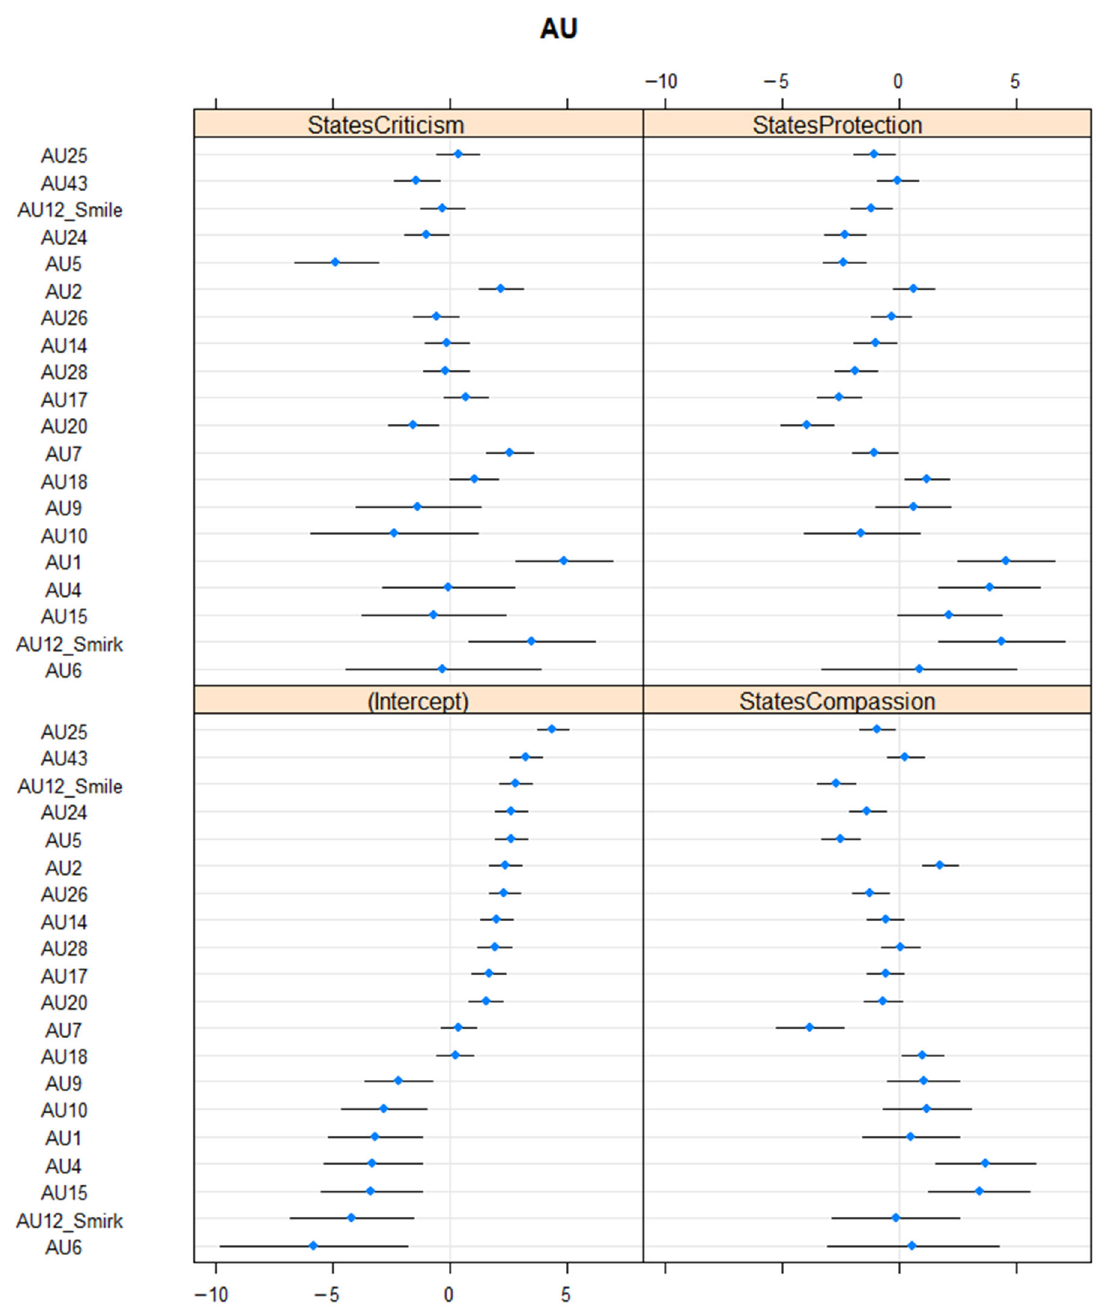
Figure 1. FrequencyofActionUnits—DifferencesBetweenStates. Note. Intercept—baseline,StatesCompassion— Figure 1. Frequency of Action Units—Differences Between States. Note. Intercept—baseline, self-compassion, StatesCriticism—self-criticism, StatesCompassion—self-compassion, StatesCriticism—self-criticism, StatesProtection—self- protection.